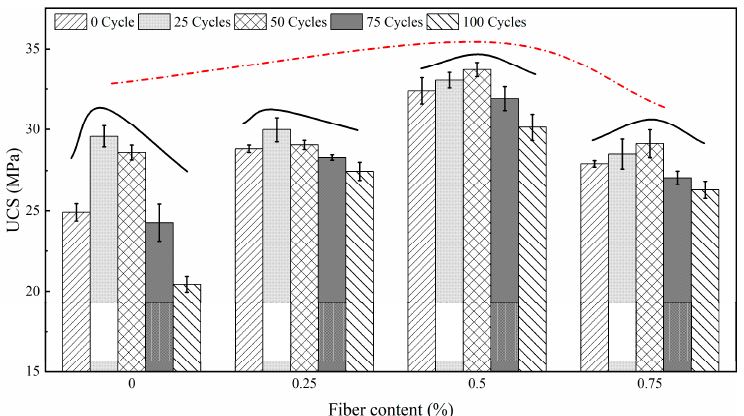
Figure 6. UCS of cement mortar under freeze-thaw cycles.